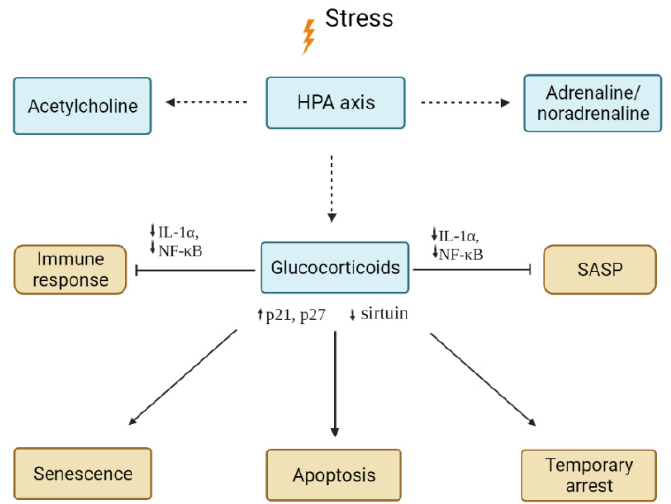
Figure 2. Schematic representation of effects of glucocorticoids on intracellular processes and signalling pathways related to senescence, apoptosis, and cell cycle regulation. ↑ —stimulation, ↓ —inhibition.